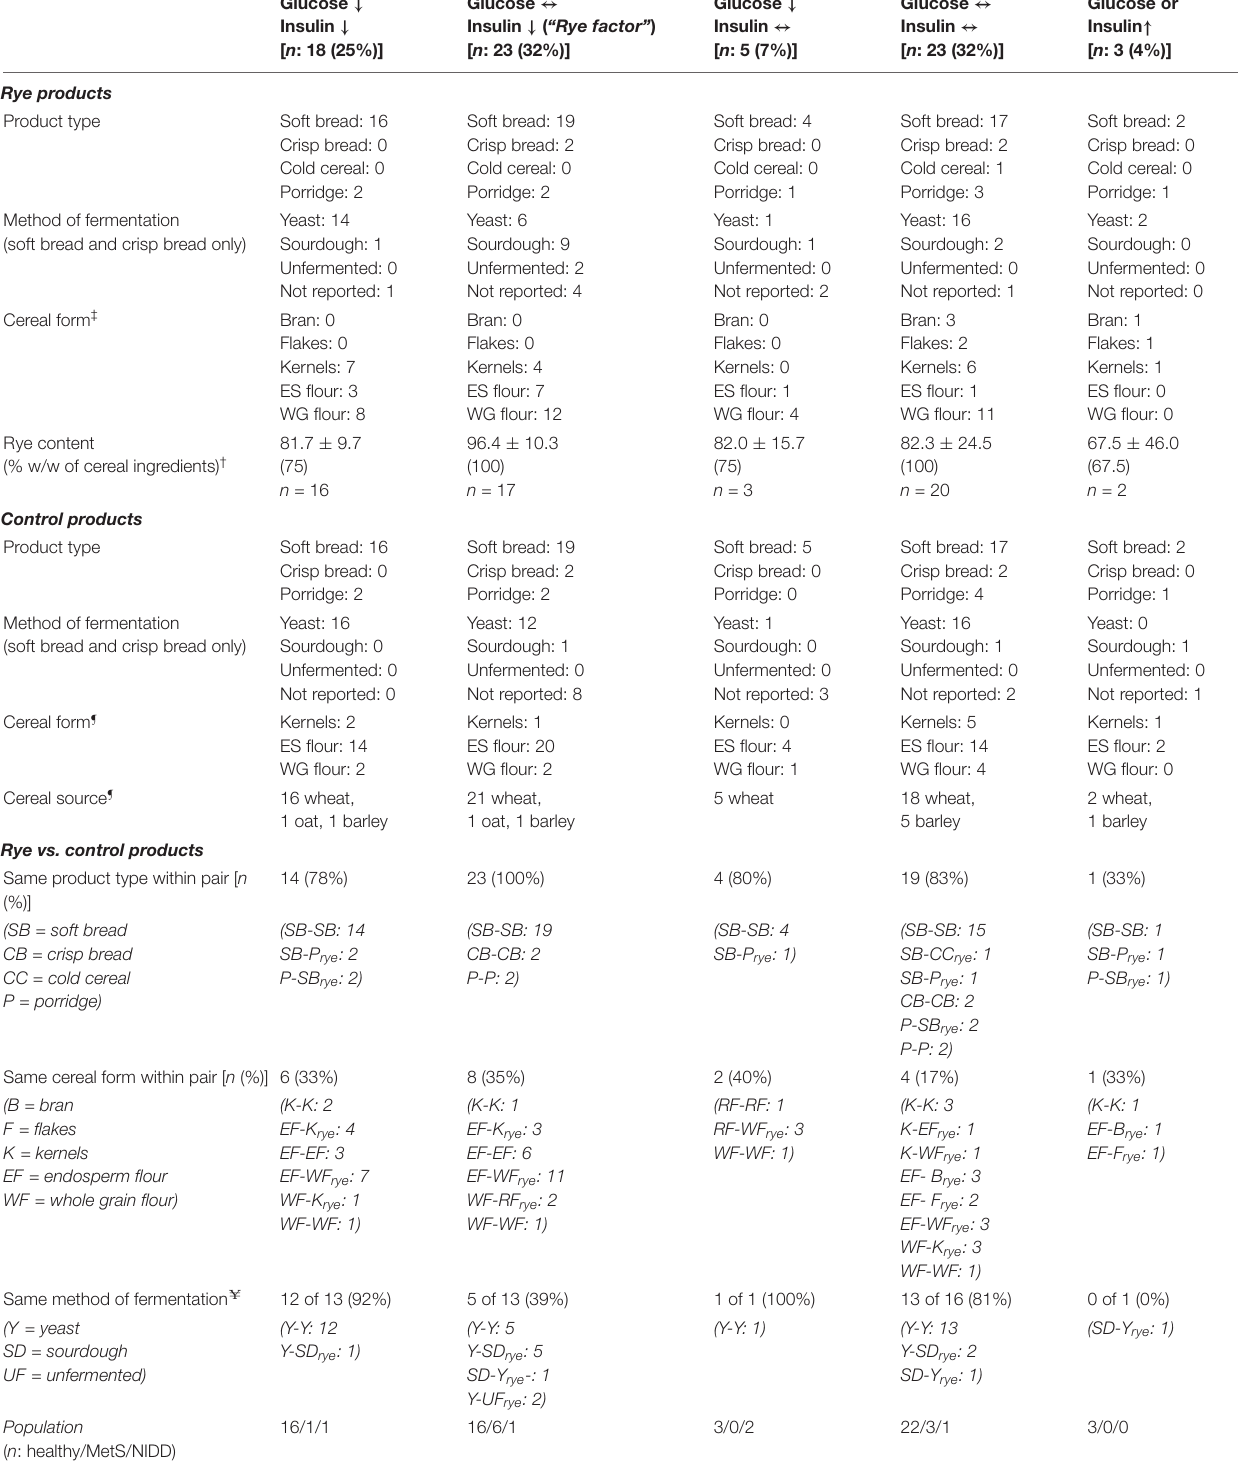
TABLE 1 | Pairs of rye-control comparisons extracted from the studies presented in Supplementary Table 1 , grouped according to effect on postprandial insulin and glucose. Glucose ↓ Insulin